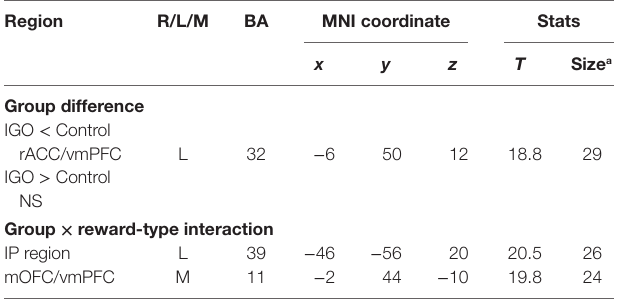
TaBle 2 | Brain regions showing group differences in response to